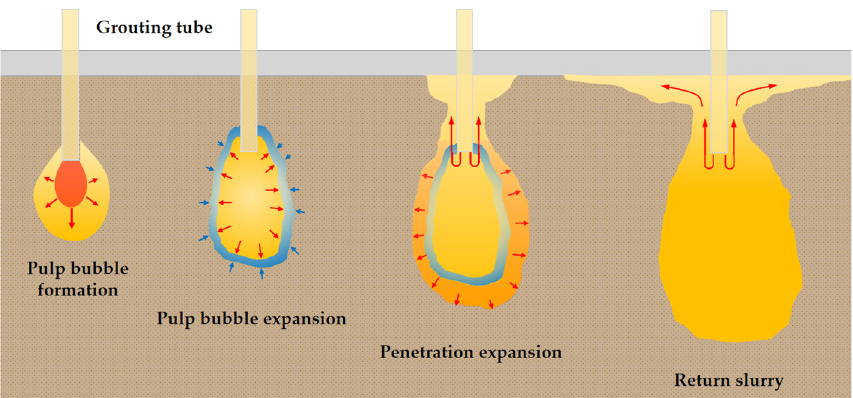
Figure 12. Schematic diagram of the slurry low ‐ pressure diffusion process.